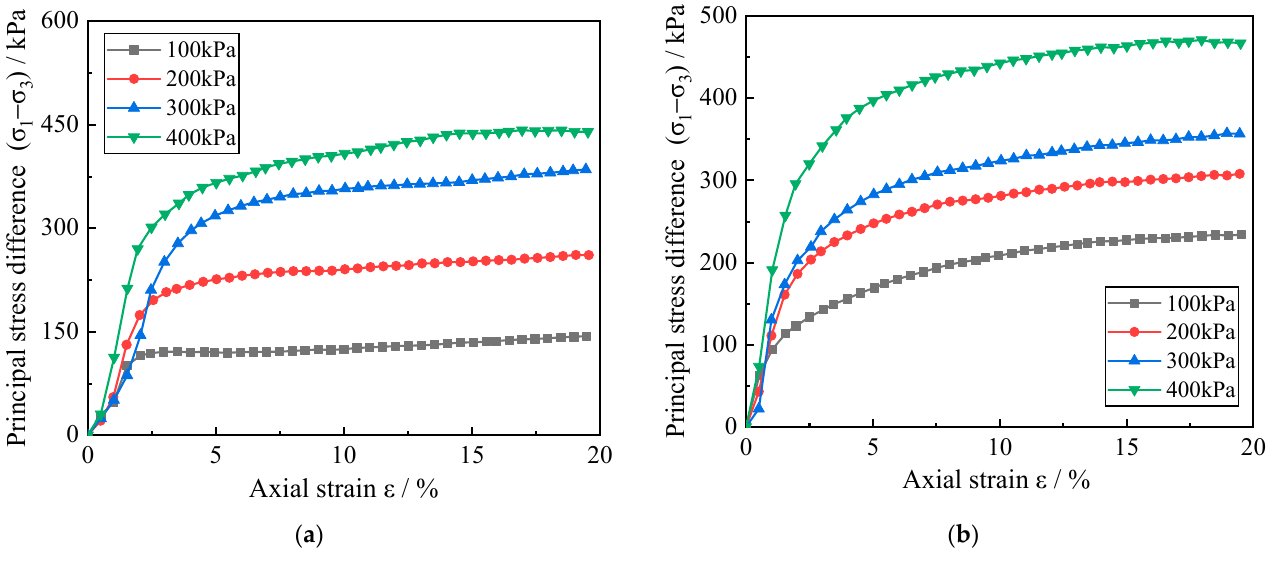
Figure 4. Stress–strain curves of zinc-contaminated red clay under different confining pressures. ( a ) The temperature is 8.3 °C, and the zinc ion concentration is 0.05%; ( b ) The temperature is 40 °C, and the zinc ion concentration is 0.5%.